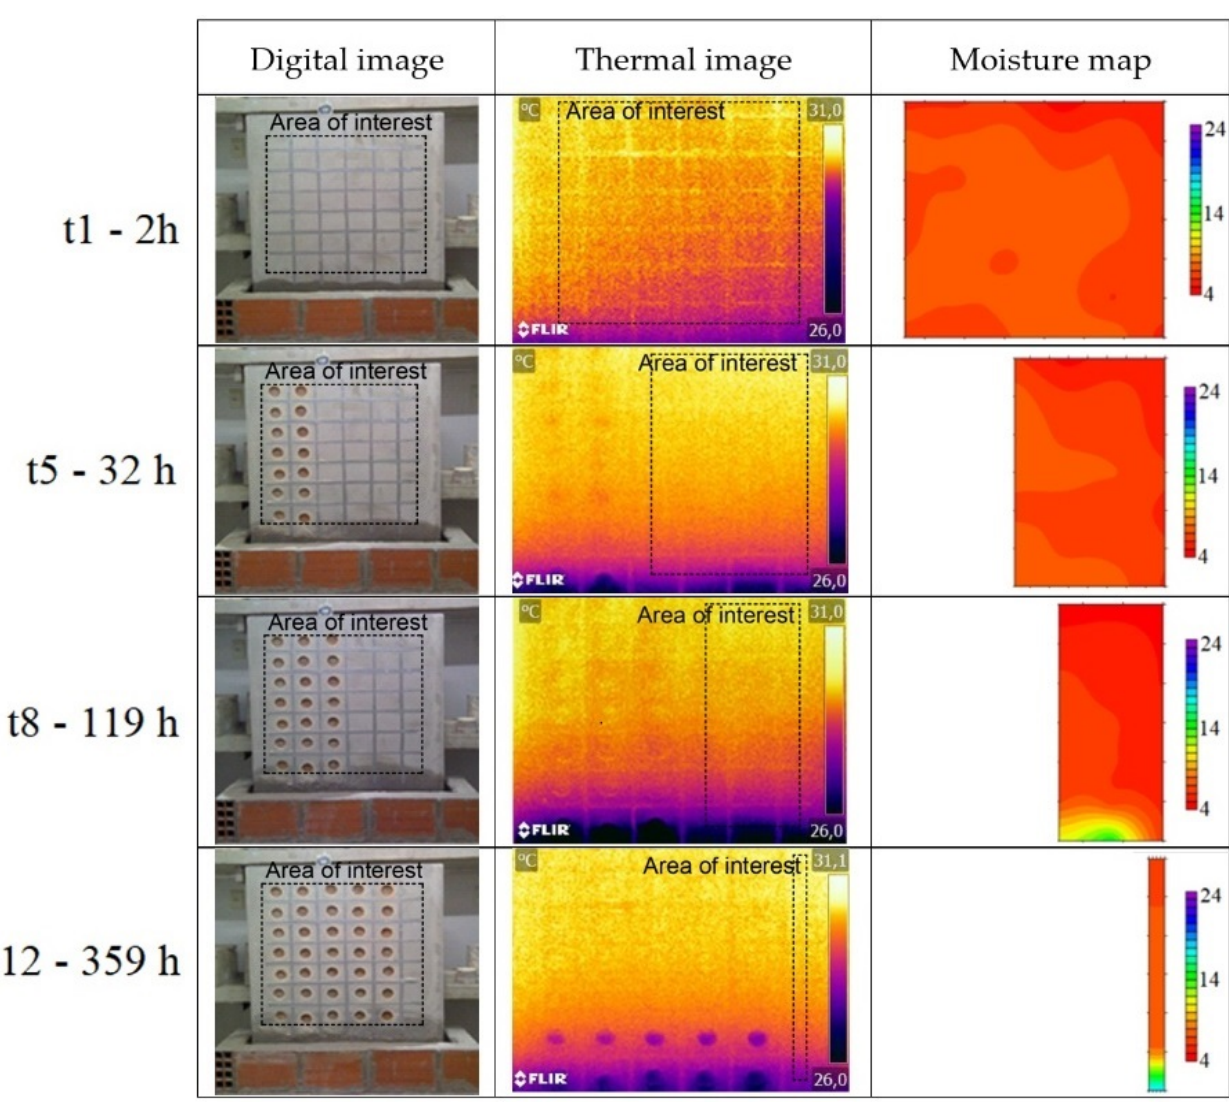
Figure 6. Digital images, thermal images, and moisture maps of the humidification test of the wall in the hot chamber.